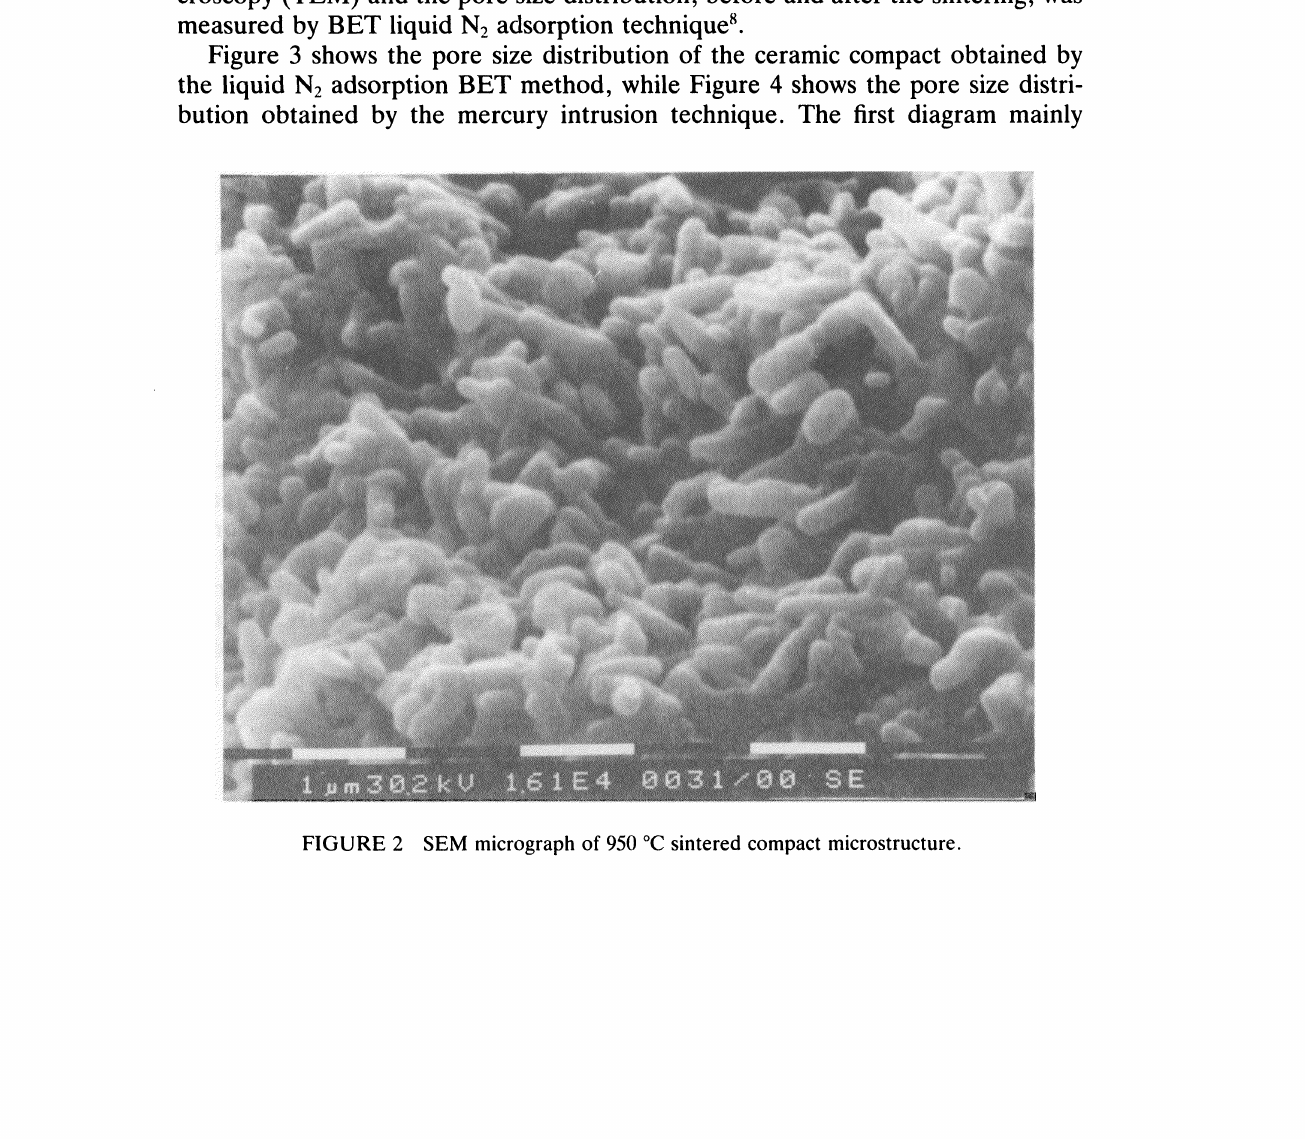
FIGURE 2 SEM micrograph of 950 C sintered compact